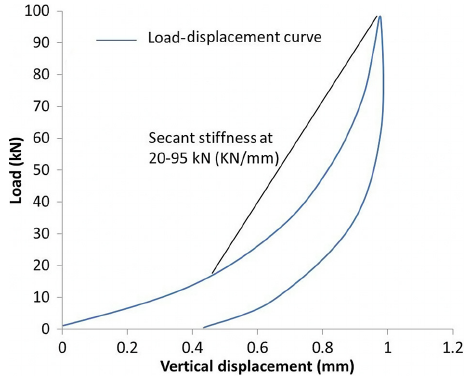
Fig. 2. Load-displacement curve, as recorded in the 20–95 kN static